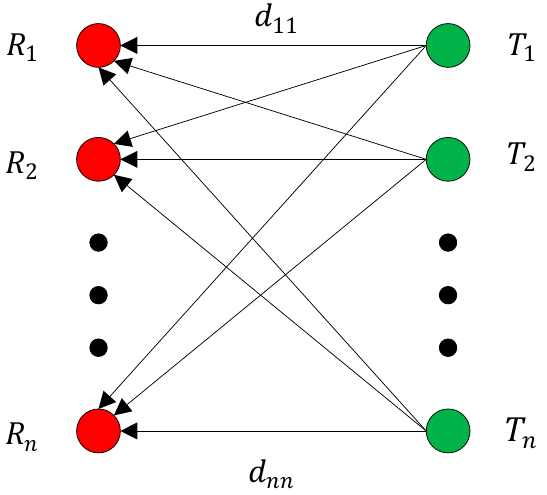
Figure 2. Schematic representation of 𝑛 × 𝑛 channel.